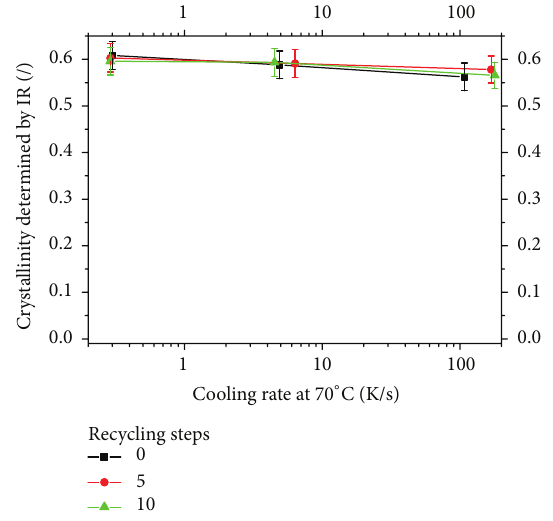
Figure 4: Overall crystallinity degree as assessed by IR spec-